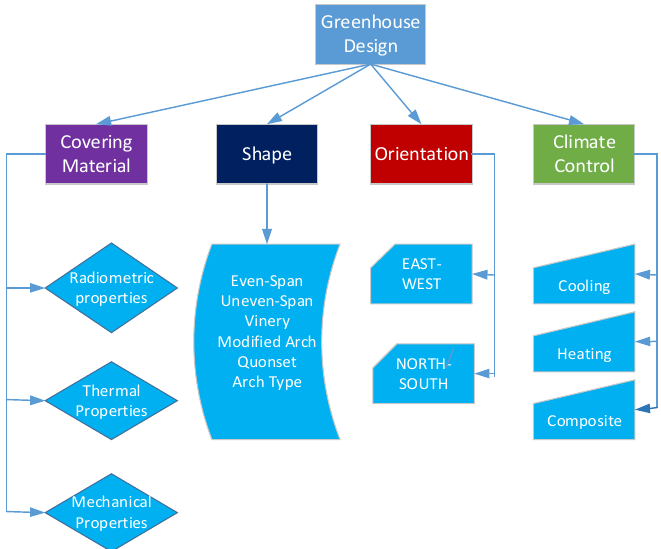
Figure 17. Greenhouse design components.